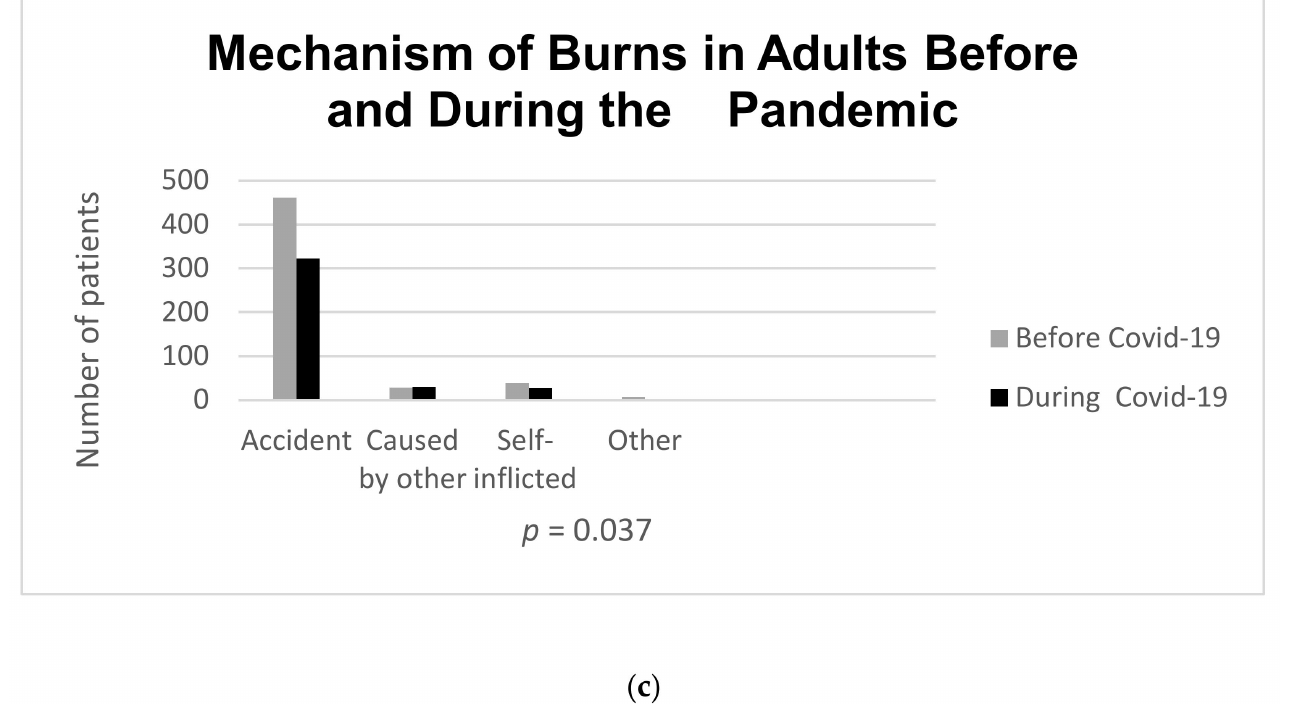
Figure 2. ( a ) Cause of Burns in Adults Before and During the Pandemic: comparison of adult burn patient cause and pandemic (before/during)—Fisher’s exact test, p -value = 0.245. ( b ) Mechanism of Burns in Adults Before and During the Pandemic. Mechanism of Burns in Adults, Before and During the Pandemic. Comparison of adult burn patient mechanism and pandemic (before/during)— Fisher’s exact test, p -value = 0.037. ( c ) Place of Burns in Adults, Before and During the Pandemic: com- parison of adult burn patient place and pandemic (before/during) Chi-squared test, p -value =